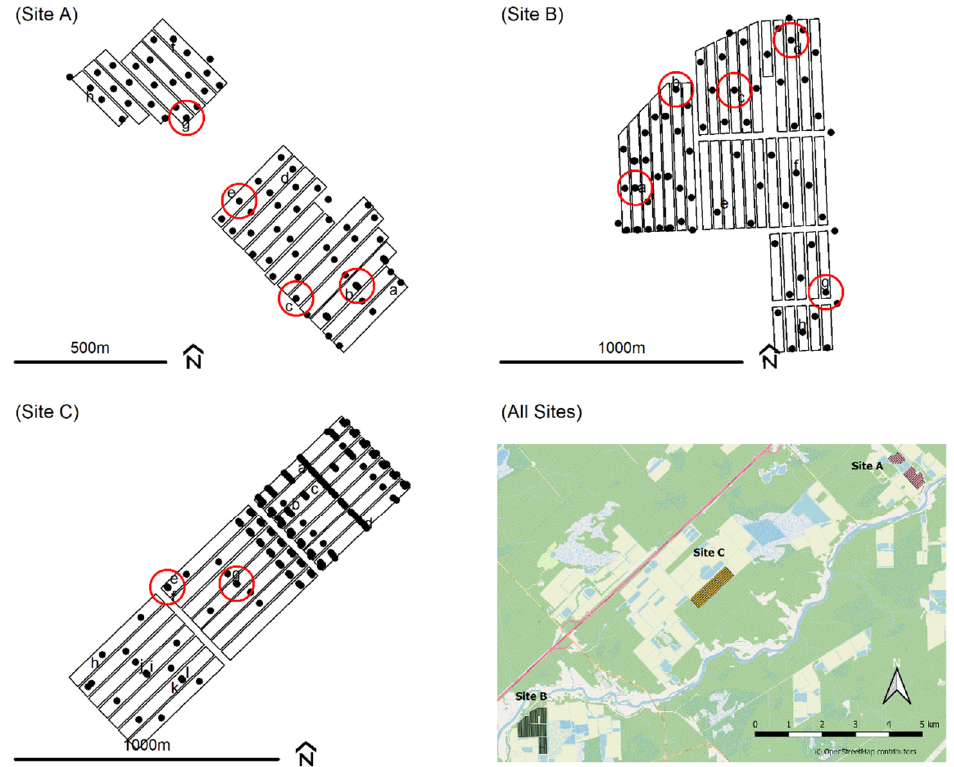
Figure 1. Observation wells of the three cranberry farms: Site A, Site B, Site C, and a geographical representation of all Sites. Circles are the instrumented wells for years 2017, 2018, 2019, and 2020.